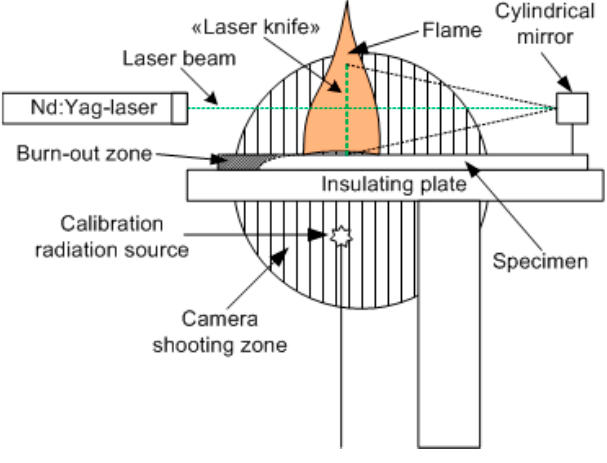
Figure 3 . Configuration of the experimental setup. Figure 3. Configuration of the experimental